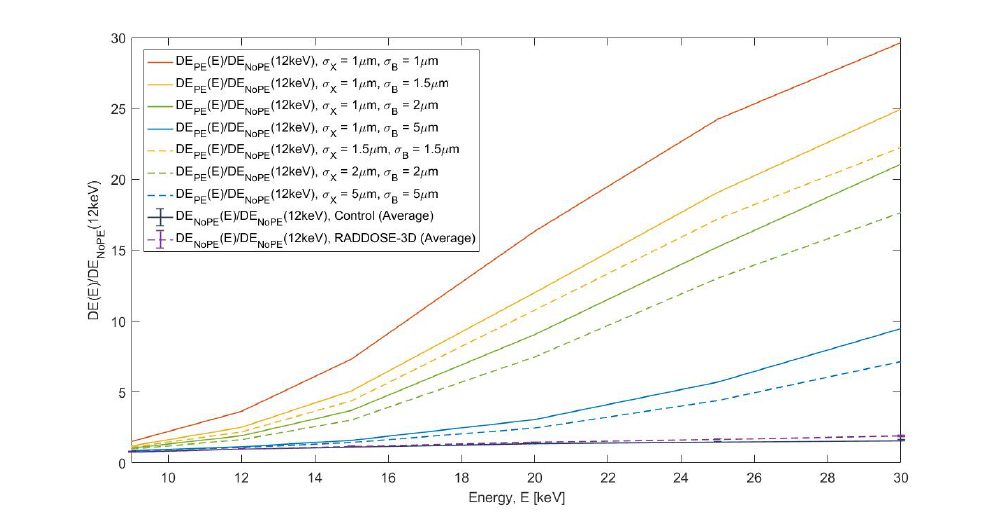
Figure 4. Diffraction efficiency, DE ( E ) , of simulated results with PE escape ( DE PE ) and without PE escape ( DE NoPE ) incorporated. Red, orange, green, and blue lines (both solid and dashed) are for DE PE , crystals and beams between 1µm and 5µm, respectively, as shown in the legend. The solid dark blue line is the average of DE NoPE , as determined by our control simulations, across all crystal and beam sizes, with error bars showing standard deviation. The dashed purple line shows the average for RADDOSE-3D results. As the standard deviation within each set is (cid:54) 3% for all energies, the error bars are only resolvable on some data points. The reference value was the value of DE NoPE ( 12keV ) calculated with RADDOSE-3D; all values of DE PE ( E ) and DE NoPE ( E ) are relative to this reference.